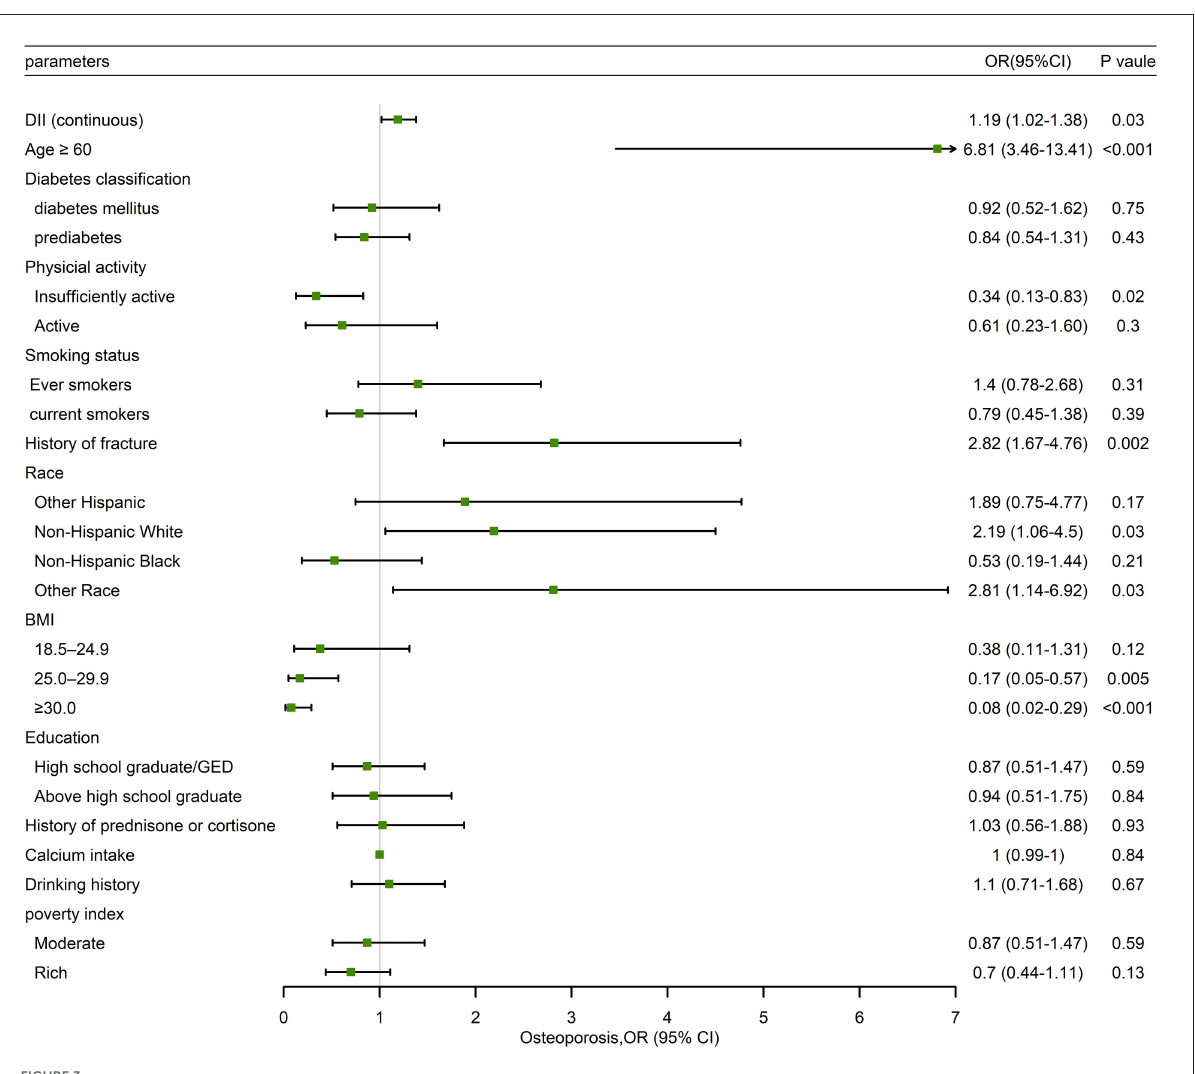
FIGURE3 Forest plot of weighted multivariable logistic regression analysis model in participants demonstrating the association between MDII score and